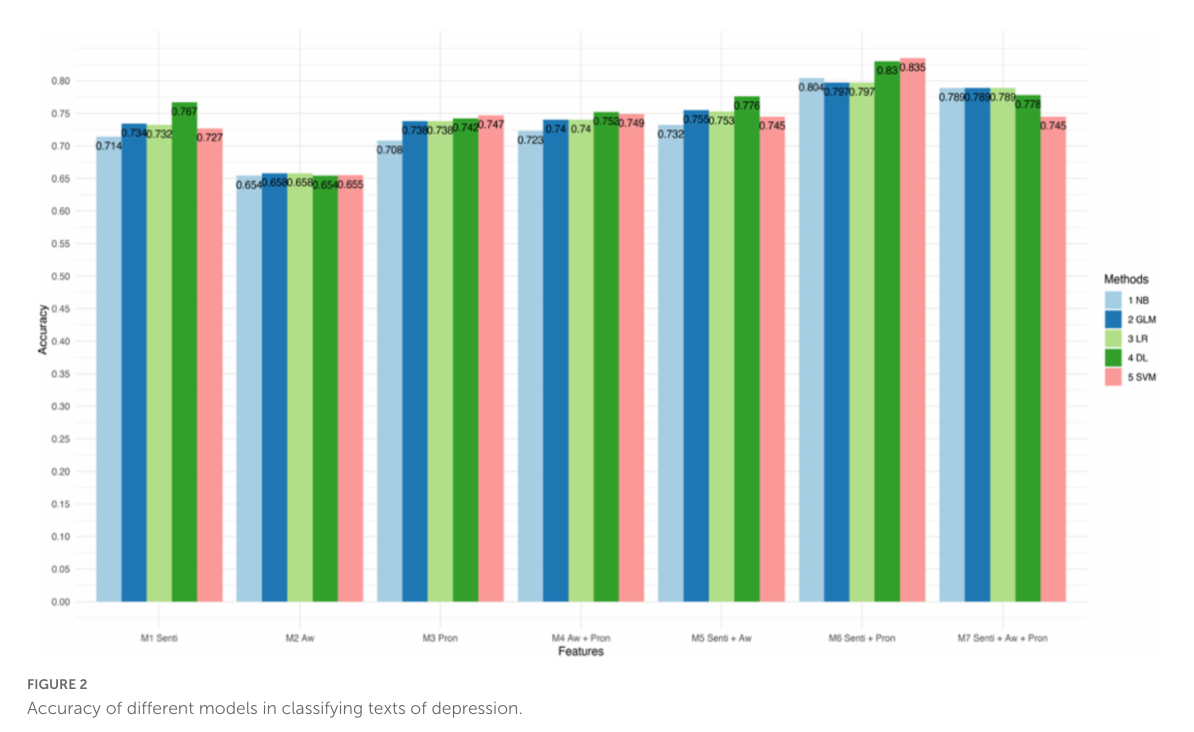
FIGURE2 Accuracy of different models in classifying texts of depression.